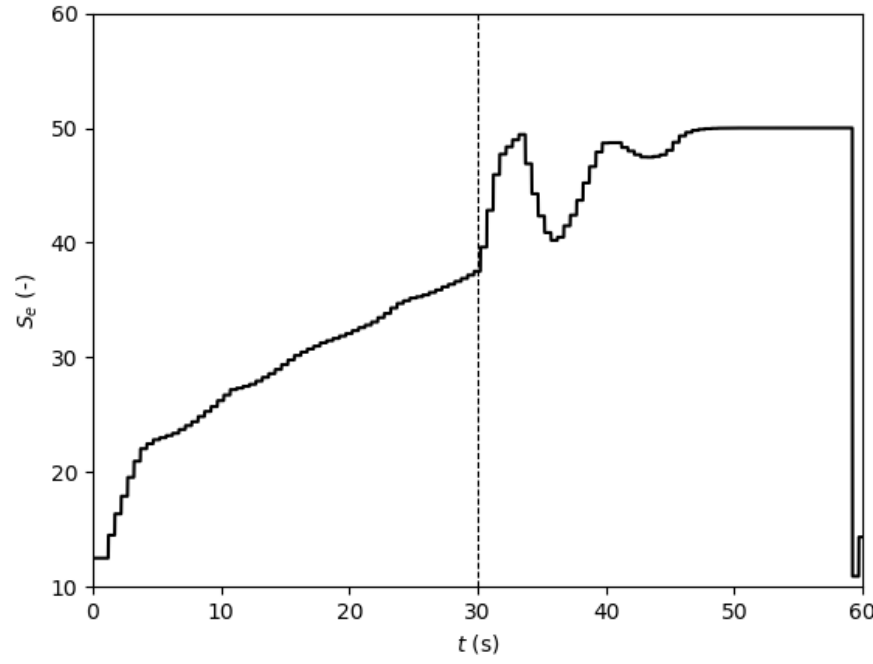
Figure 23. Effective swirl number profile, feedback with complete regulation law, case